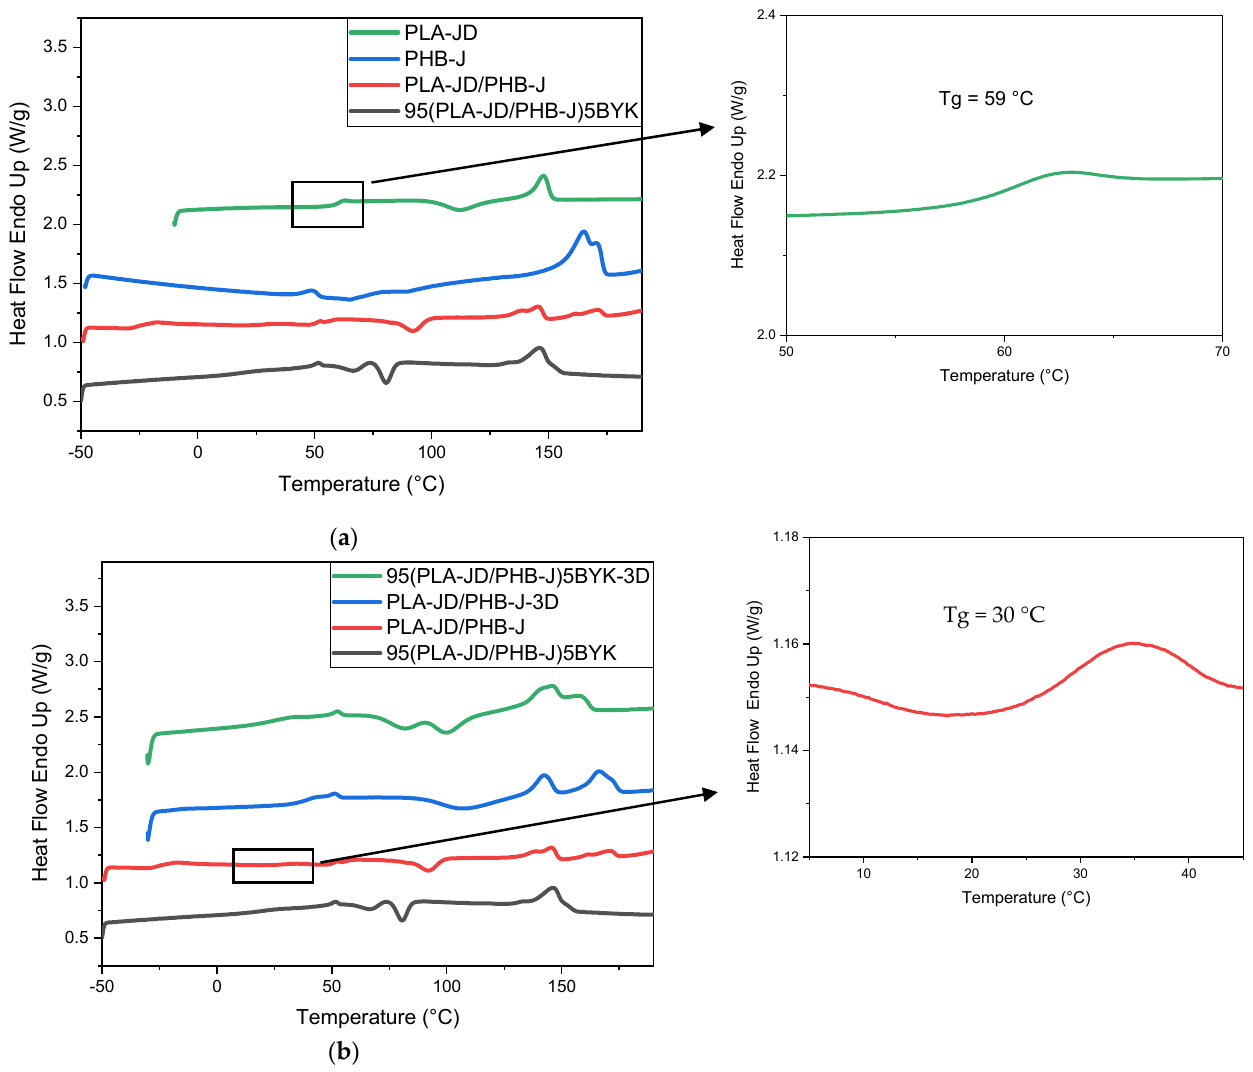
Figure 7. DSC thermograms of ( a ) the sample processed through injection molding and ( b ) a comparison between the samples processed by injection molding vs. 3D printing. Table 4. Temperature and degree of crystallinity measured in the DSC thermograms.